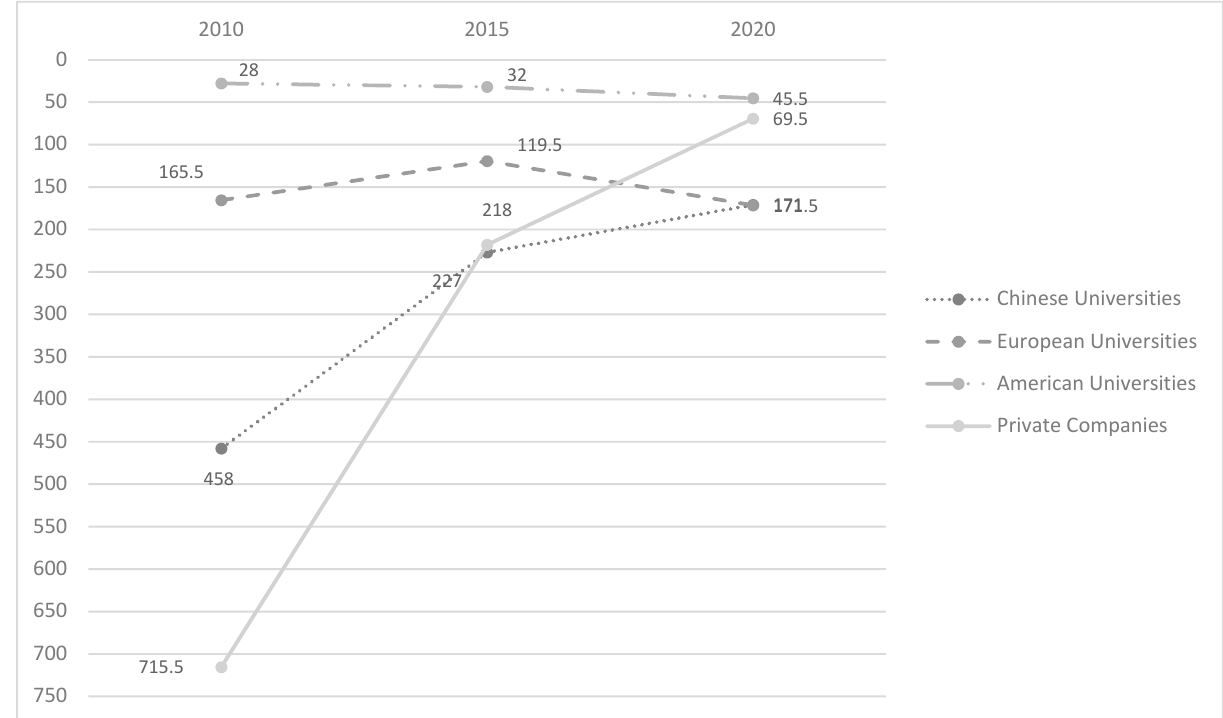
Figure 1. Trends 2010–2020 on SCImago institutions rankings (SIR) of the best 30 universities of China, the European Union, the US, and of the best 30 private companies.